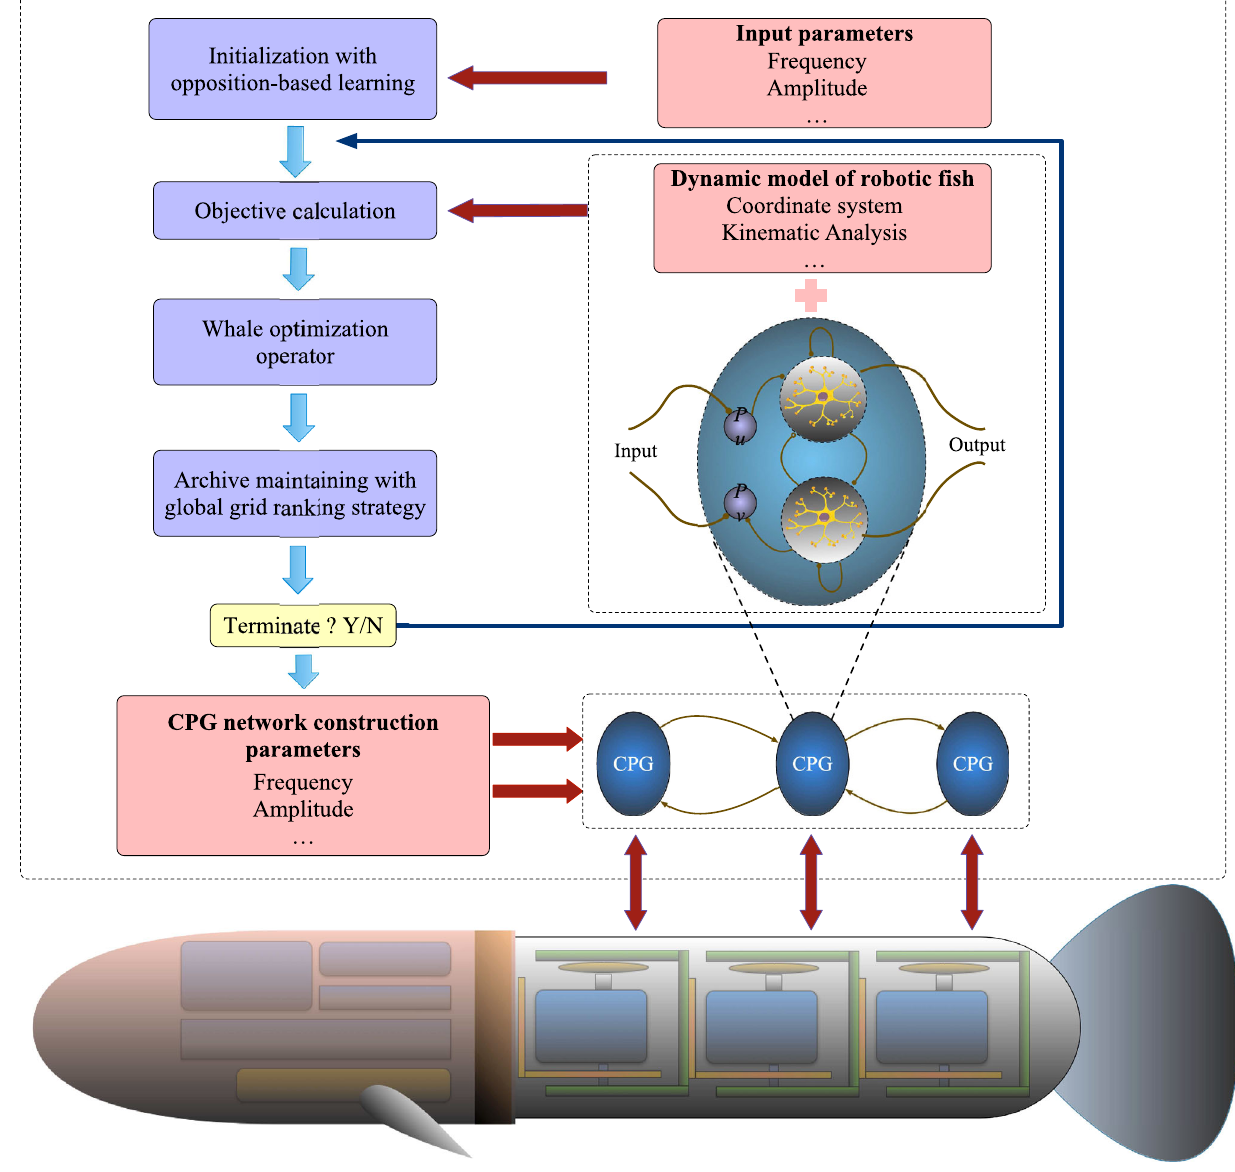
Fig. 3 Configuration of the multi-objective evolutionary design of the CPG model in our proposed biomimetic robotic fish